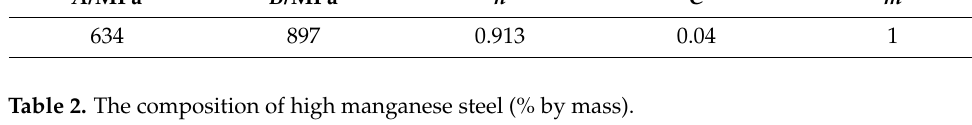
Table 2. The composition of high manganese steel (% by mass).